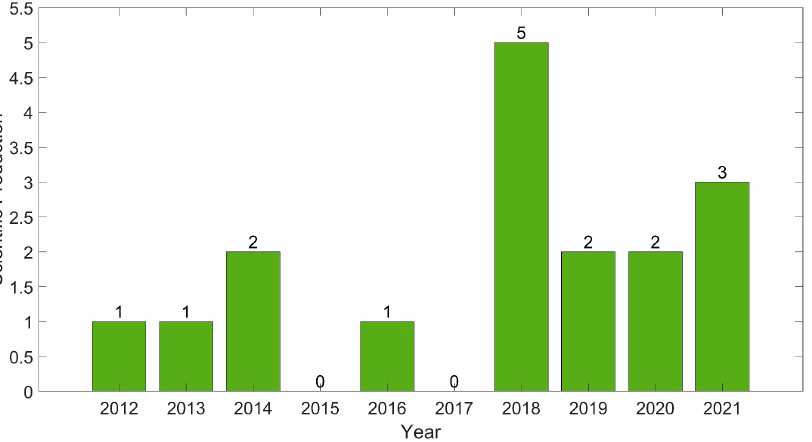
Figure 2. Number of scientific productions between 2012 and 2021 for the keywords “cyber-physical system” and “chemical engineering”.